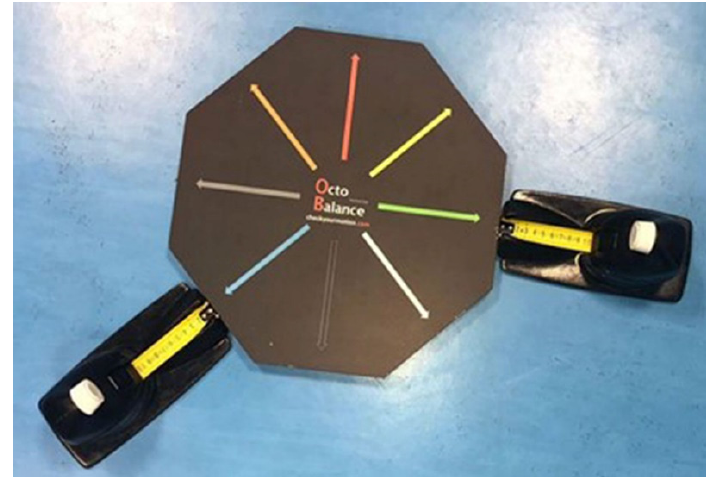
Figure 1. OctoBalance Test.